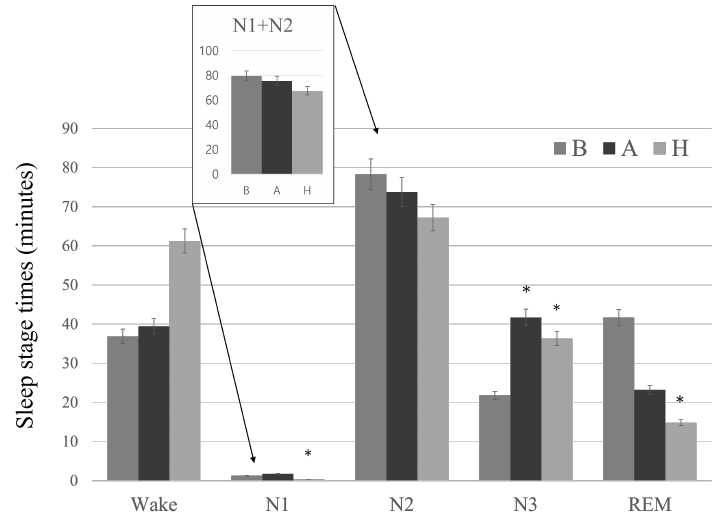
Figure 9. Estimated each sleep stage lengths of 15 participants during proposed nap experiments in the recliner